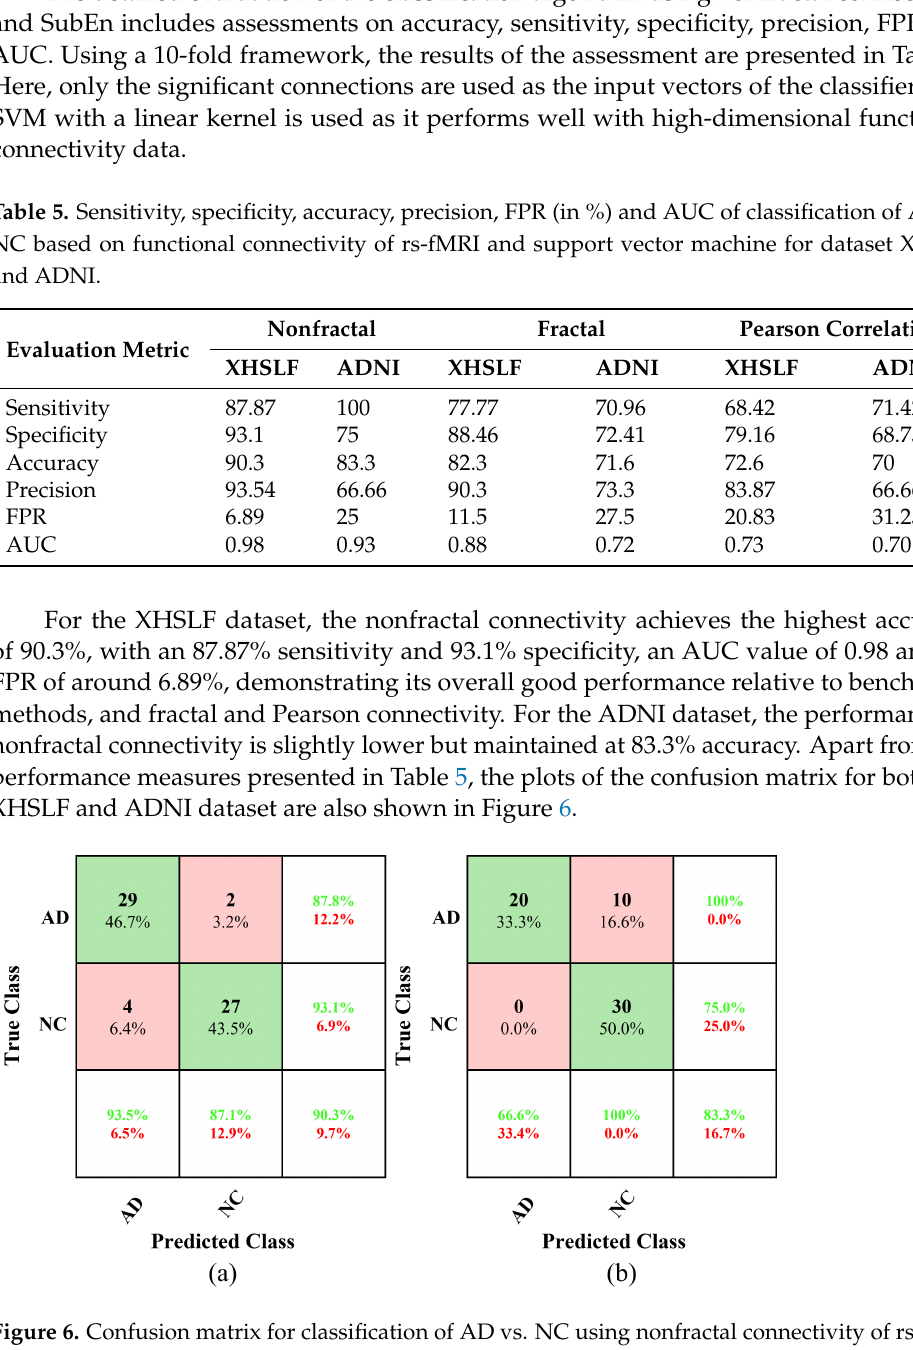
Figure 6. Confusion matrix for classification of AD vs. NC using nonfractal connectivity of rs-fMRI as input feature vectors to SVM classifier for dataset ( a ) XHSLF and ( b ) ADNI. With nonfractal AUC values of 0.99 and 0.95 for the XHSLF and ADNI datasets, respectively, this indicates that the model yields a high true positive rate and low